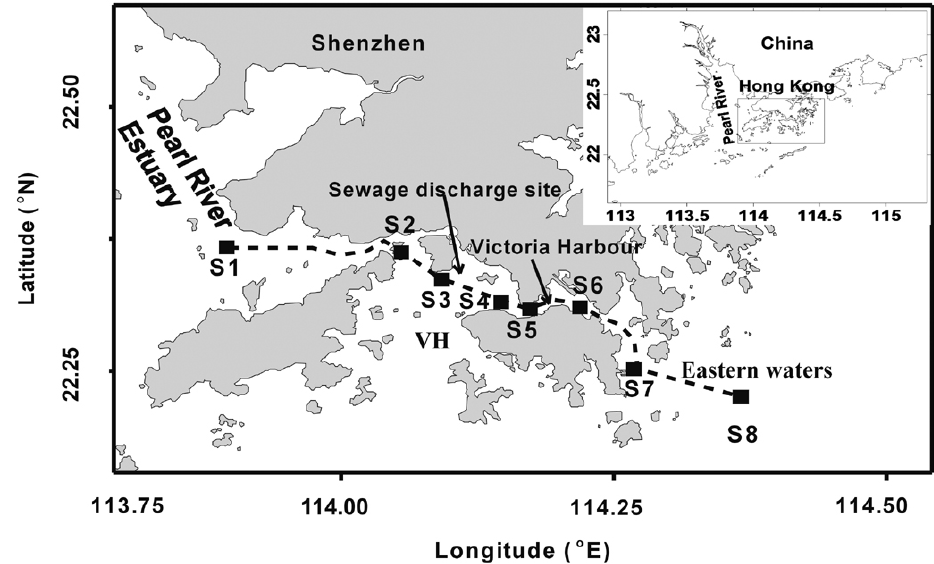
Fig. 1. Map and sampling stations along a transect from S1 near the Pearl River estuary to S8 in eastern coastal/shelf waters. The sewage discharge site is located between S3 and